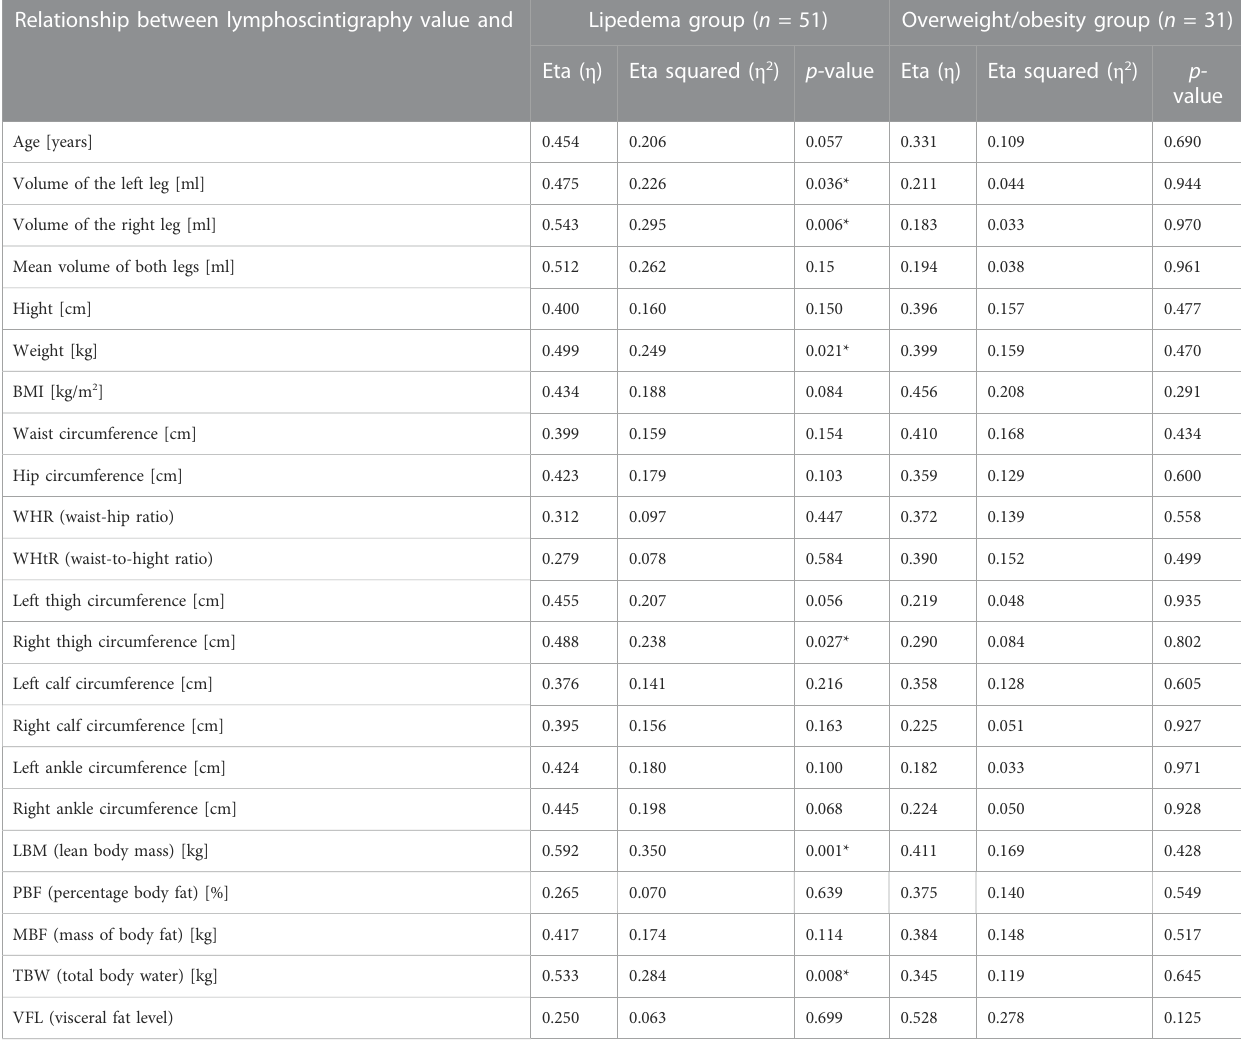
TABLE 4 The relationship between the lymphoscintigraphy values and other clinical parameters in the study groups. Relationship between lymphoscintigraphy value